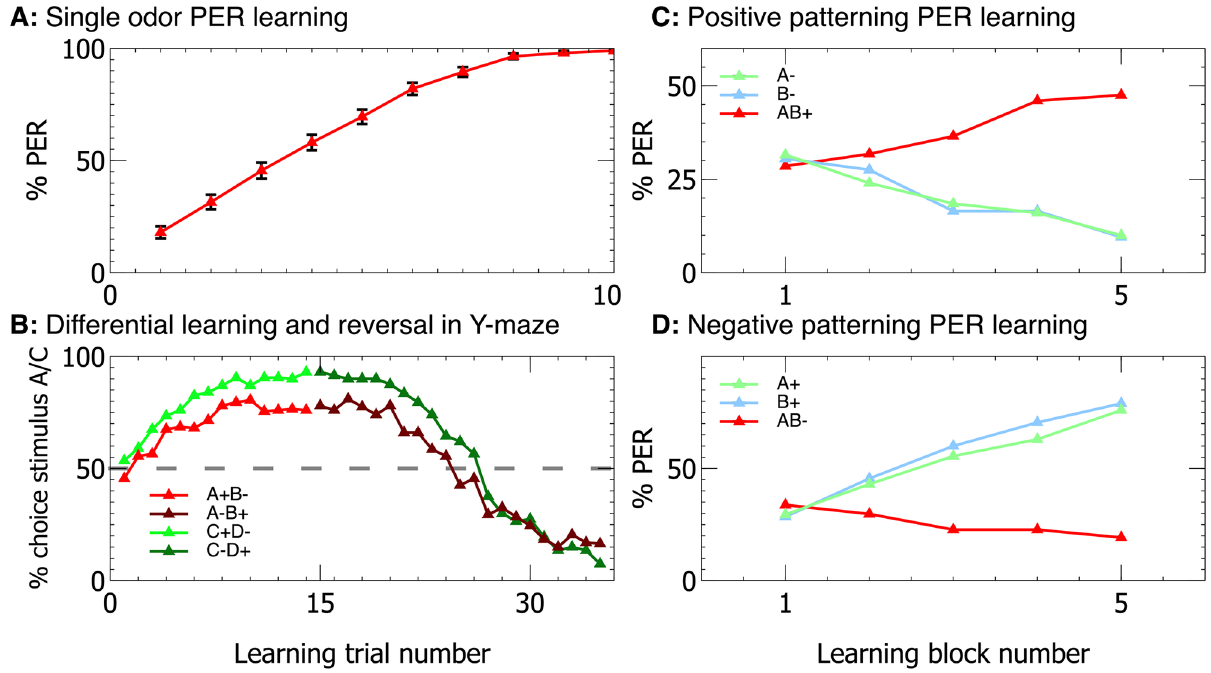
Fig 3. The full model is capable of performing a range of conditioning tasks. With modification of only the experimental protocol, our full model can successfully perform a range of conditioning tasks which can be performed by restrained (using the Proboscis Extention Reflex (PER) paradigm) and free flying bees. Performance closely matches experimental data with real bees (e.g. A : [46], B : [47], C & D :